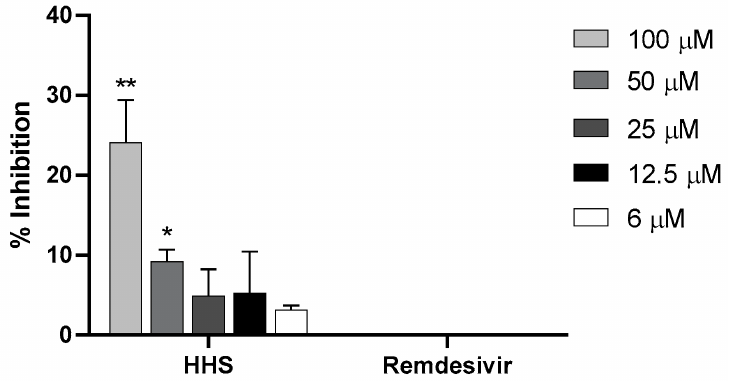
Figure 7. Percentages of inhibition of RBD-ACE2 binding (y-axes) after pre-incubation for 3 h at RT with various concentrations of HHS and remdesivir (x-axes) followed by a 3 h overlay onto plate- bound ACE2. Bound RBD was detected with a mouse monoclonal anti-His antibody followed by a HRP-labelled anti-mouse IgG 1 antibody and detected with ABTS. Values represent the means ± SD of three determinations. Asterisks (*, **) indicate significantly different ( p < 0.5 and p < 0.01, respectively) in comparison to 6 µ M HHS (non-parametric unpaired t